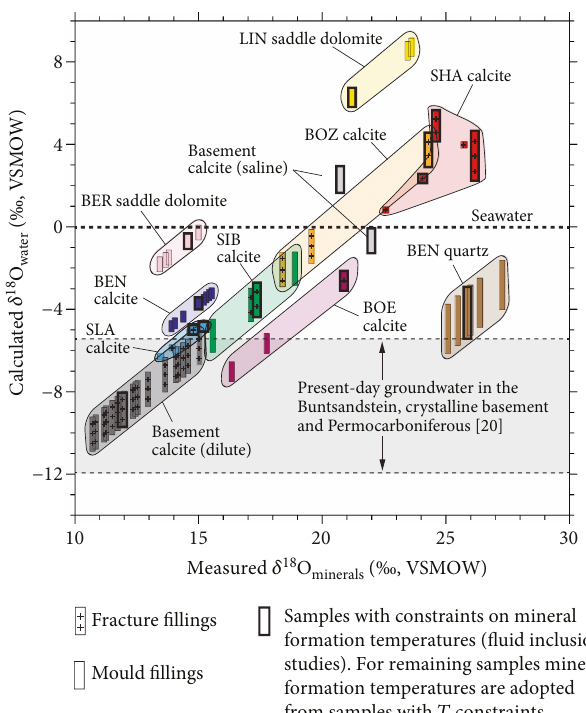
Figure 11: Measured and calculated oxygen isotopic compositions of parent-waters of secondary carbonates and quartz, as well as literature data for the recent groundwater in the crystalline basement (grey area; [20]). The ranges of calculated δ 18 O of the parent waters result from the ranges of fl uid inclusion trapping temperatures shown in Figure 10 and Table